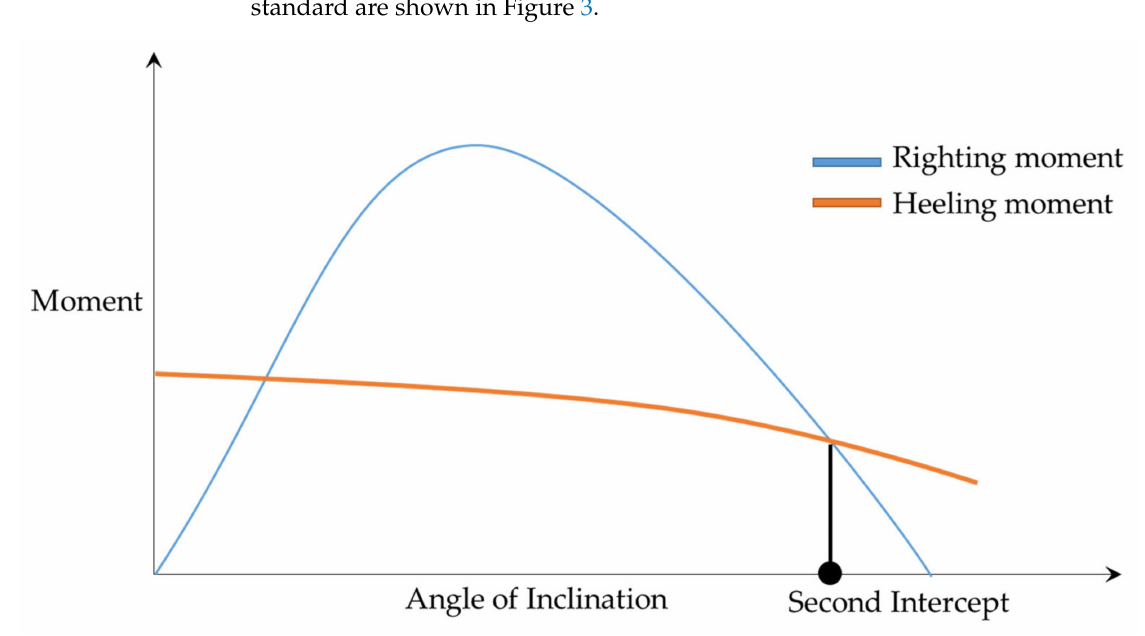
Table 2. Requirements set by standards.